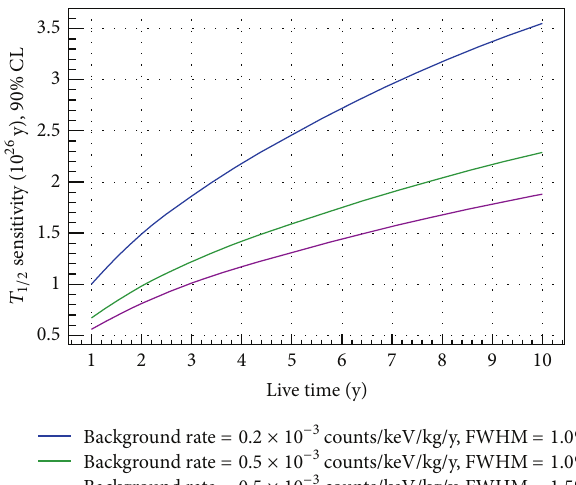
Figure 7: Sensitivity projections for 116 Cd for a large-scale experi- ment as described in the text, using various background rates and energy